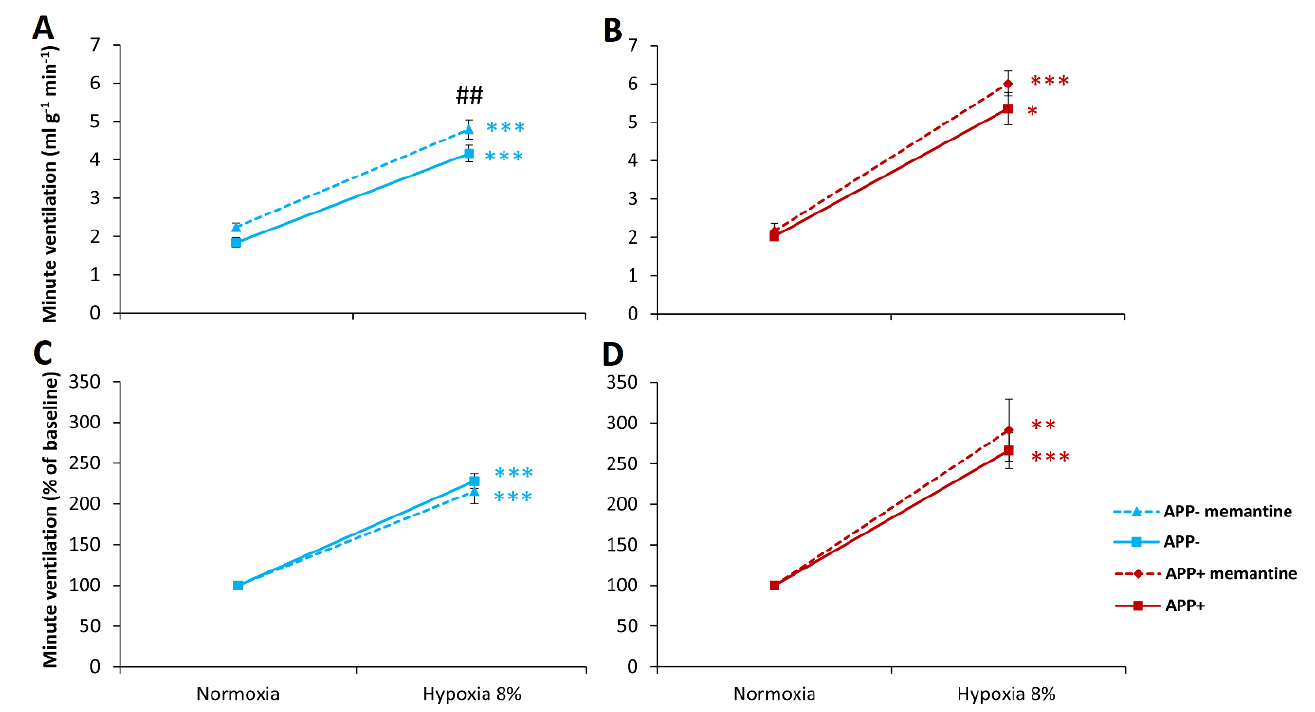
Figure 2. Minute ventilation (V E ) during air breathing (normoxia) and ventilatory response to hypoxia in APP+ (red line) and APP − mice (blue line) before (solid line) and after memantine injection (dashed line) ( A , B ). Minute ventilation expressed as a percentage of baseline (normoxia) values ( C , D ). Note the lack of difference in hypoxia reactivity in the two groups of mice. The data are presented as mean ± SEM; * p < 0.05, ** p < 0.01, *** p < 0.001 vs. normoxia value, ## p < 0.001 vs. pre-memantine state (n = 6 for APP+ and APP − ). Table 2. Tidal volume (V T ) and frequency of breathing (F) baseline values during air breathing (normoxia) and hypoxia in APP+ and APP − mice before and after memantine injection. In the two right columns, V T and F during the respiratory response to hypoxia are expressed as a percentage of baseline values in normoxia.